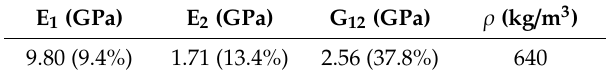
Figure 7. Effect of density on longitudinal Young modulus.